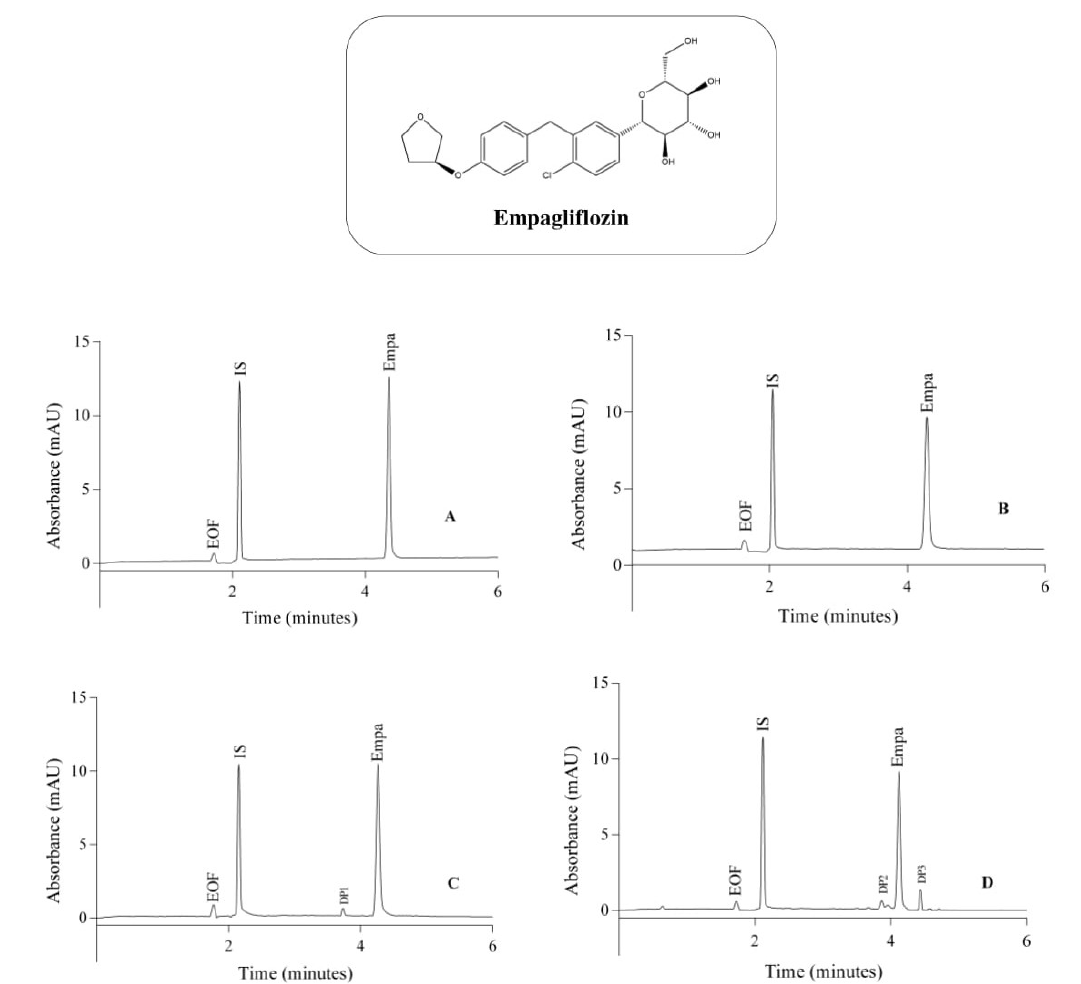
FIGURE 1 – Empagliflozin chemical structure and electropherograms from empagliflozin solutions exposed to stress testing. (A) empagliflozin standard solution. (B) non-degraded empagliflozin sample solution; (C) empagliflozin sample solution after exposure to UVA light (48 h); (D) empagliflozin sample solution after exposure to UVC light (5 h). EOF: eletroosmotic flow; IS: internal standard; DP1: degradation product 1; DP2: degradation product 2; DP3: degradation product